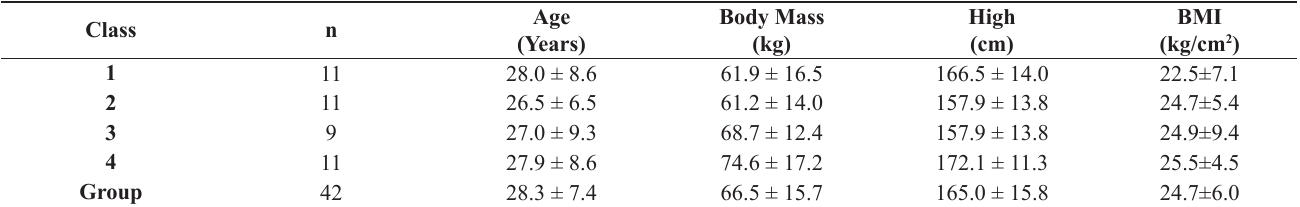
Table 1. Characteristics of participants.